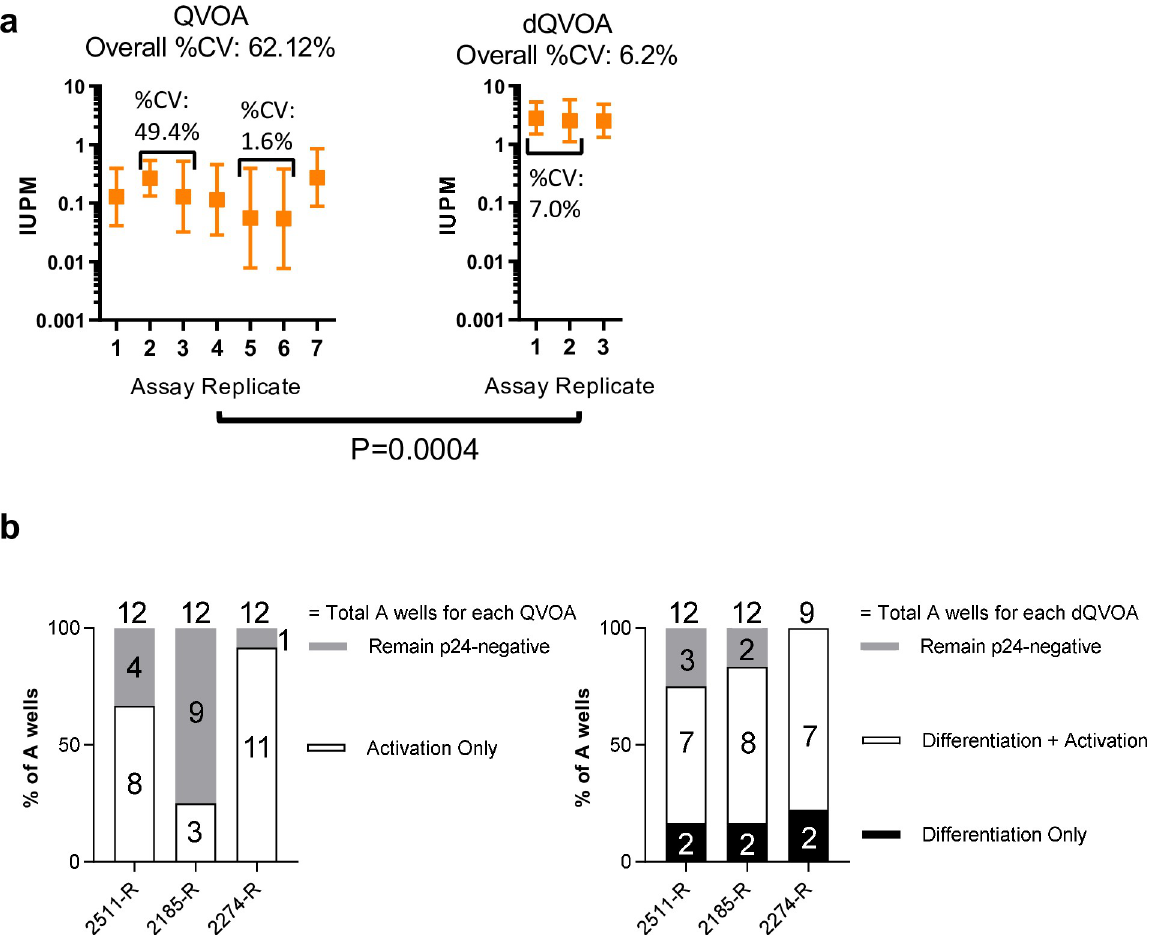
Fig 2. Ex vivo differentiation drives HIV-1 reactivation in a reproducible manner. a , Column plot showing the measured IUPM for QVOA (n = 7) and dQVOA (n = 3) performed on RAVEN participant 2147-R. Error bars are 95% confidence intervals generated by the program IUPMStats (http://silicianolab.johnshopkins.edu). %CV represents the coefficient of variation for each assay type. (p = 0.0004; unpaired t test with Welch’s correction). Black brackets indicate assays initiated on the same day and performed in parallel. %CV over each bracket represents the %CV for each batched assay set-up. b , Column plots showing the frequency of p24 positive wells after complete QVOA (left panel, white bars), differentiation alone as part of dQVOA (right panel, black bars), or after differentiation, activation, and outgrowth in complete dQVOA (right panel, white bars). For both panels, gray bars indicate the frequency of wells that remain p24 negative after completion of each assay. Frequency of HIV-1-Gag+ wells was determined using the top assay dilution for each assay.